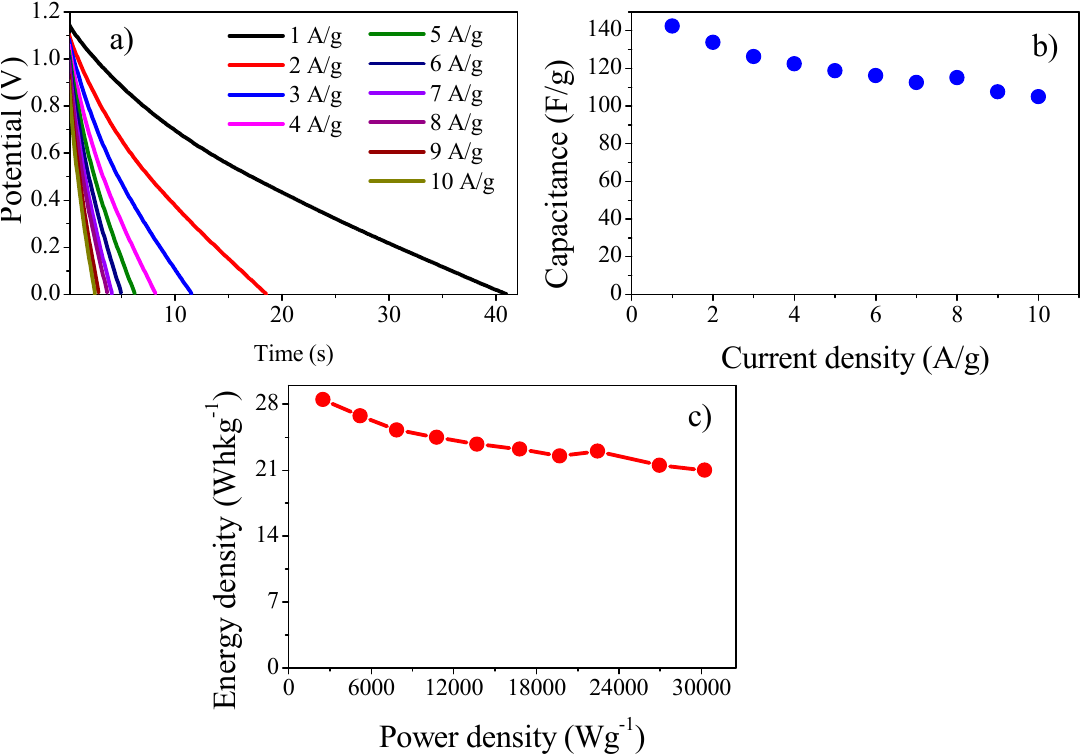
Figure 5. ( a ) Discharge curves of asymmetric devices at di ff erent current densities. ( b ) Specific capacitance versus current densities for the asymmetric device. ( c ) The Ragone plot.